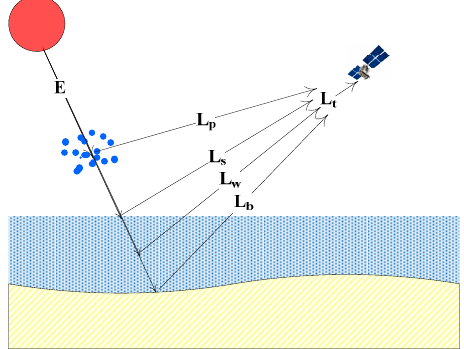
Figure 4. Interaction between electromagnetic wave and water.